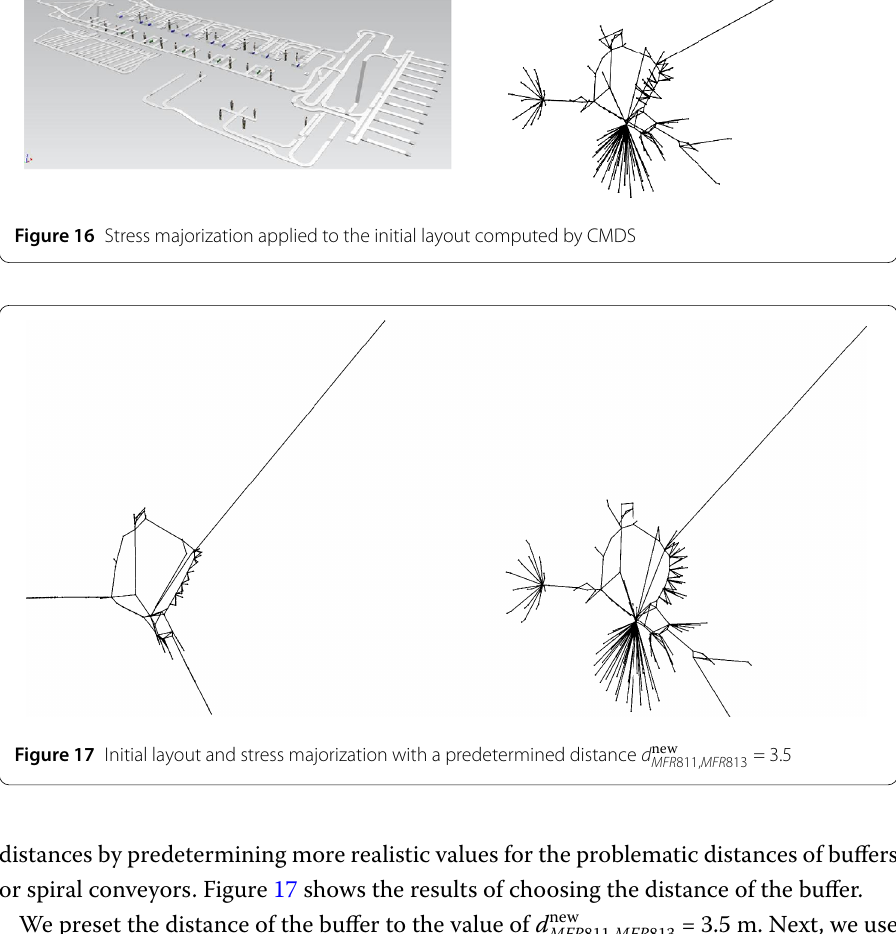
= MFR 811, MFR 813